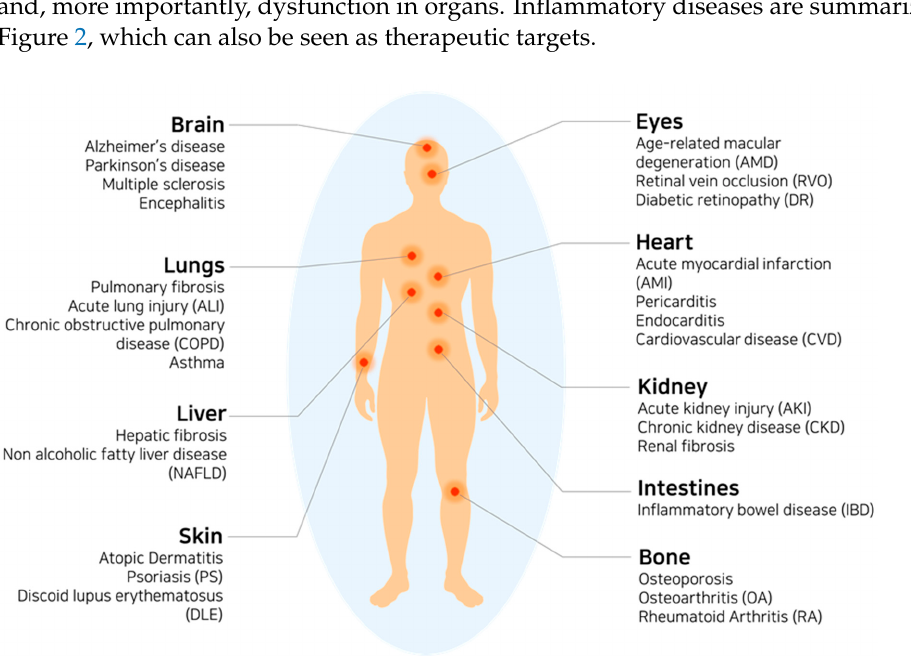
Figure 2. A schematic of the human body with inflammatory diseases.